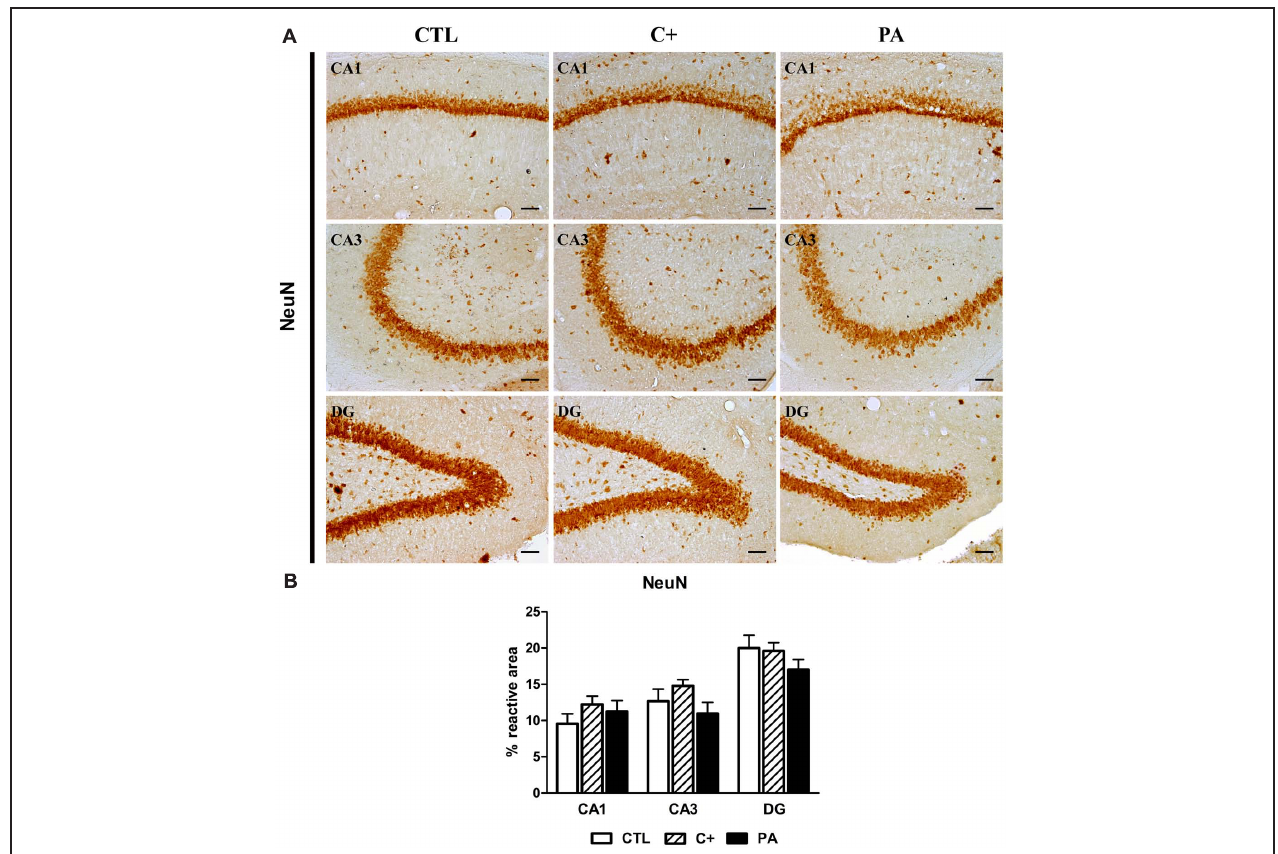
FIGURE 2 | NeuN immunostaining in dorsal hippocampus. (A) Photomicrographs of NeuN-positive cells in CA1, CA3, and DG regions of the dorsal hippocampus in CTL, C + and PA groups. Scale bars = 15 μ m. (B) Percentage of NeuN immunopositive area in CA1, CA3, and DG regions of the dorsal hippocampus in all the experimental groups. Bars and error bars show the mean + SEM of 5–7 observations per animal of a total of six rats per group. CTL, control group; C + , cesarean section group; PA, perinatal asphyxia group; CA1, cornu ammonis 1; CA3, cornu ammonis 3; DG, dentate